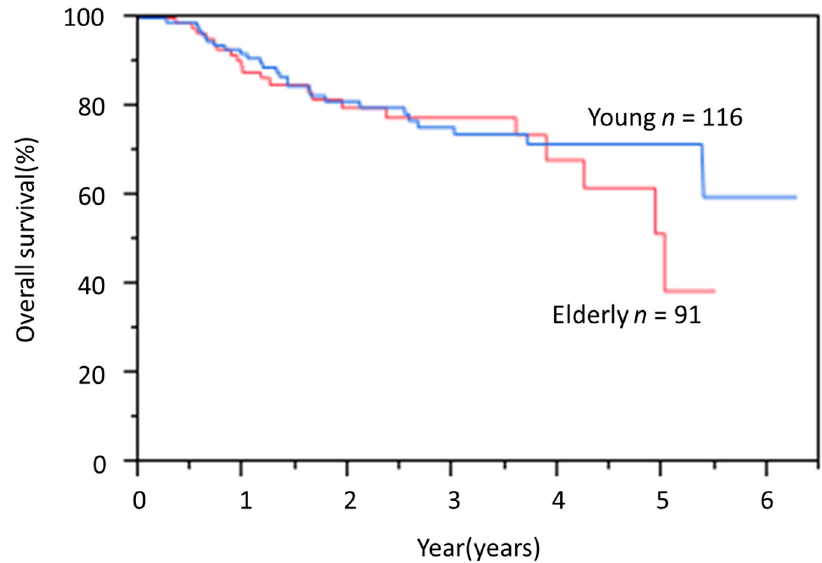
Figure 1. Kaplan-Meier overall survival (OS) curves for elderly and young groups.